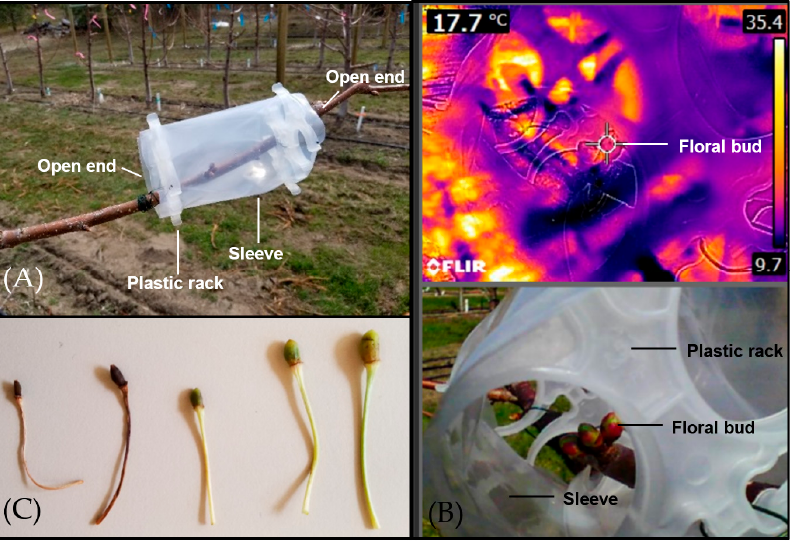
Figure 1. The installation of polyethylene sleeves to increase floral bud surface temperature (T surface ) in a ‘Lapins’/Krymsk 5 trial at SuRDC1. ( A ) The set-up of polyethylene sleeves around floral buds. ( B ) Floral bud T surface measurement using an infrared imager (photo was taken through the open end of the sleeve; top: infrared channel, bottom: RGB channel). ( C ) Ovule abortion and cessation of fruitlet development under the setting.